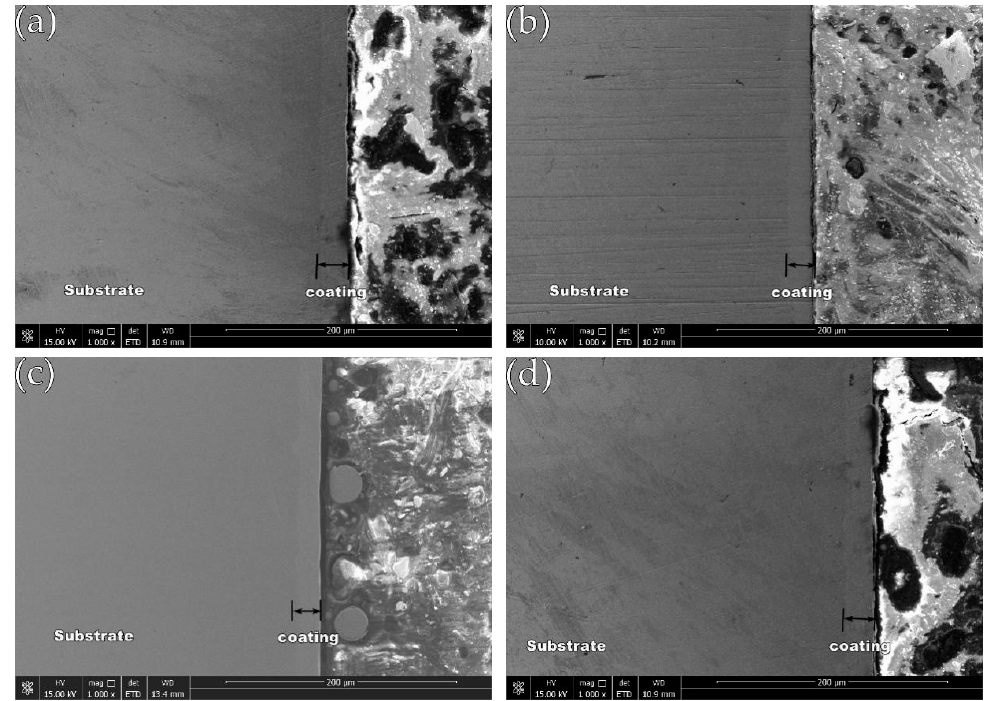
Figure 4. Cross-section morphology of the coatings: ( a ) Ni-Fe-Co-P; ( b ) Ni-Fe-Co-P-0.5 g/L CeO 2 ; ( c ) Ni-Fe-Co-P-1 g/L CeO 2 ; and ( d ) Ni-Fe-Co-P-1.5 g/L CeO 2 .